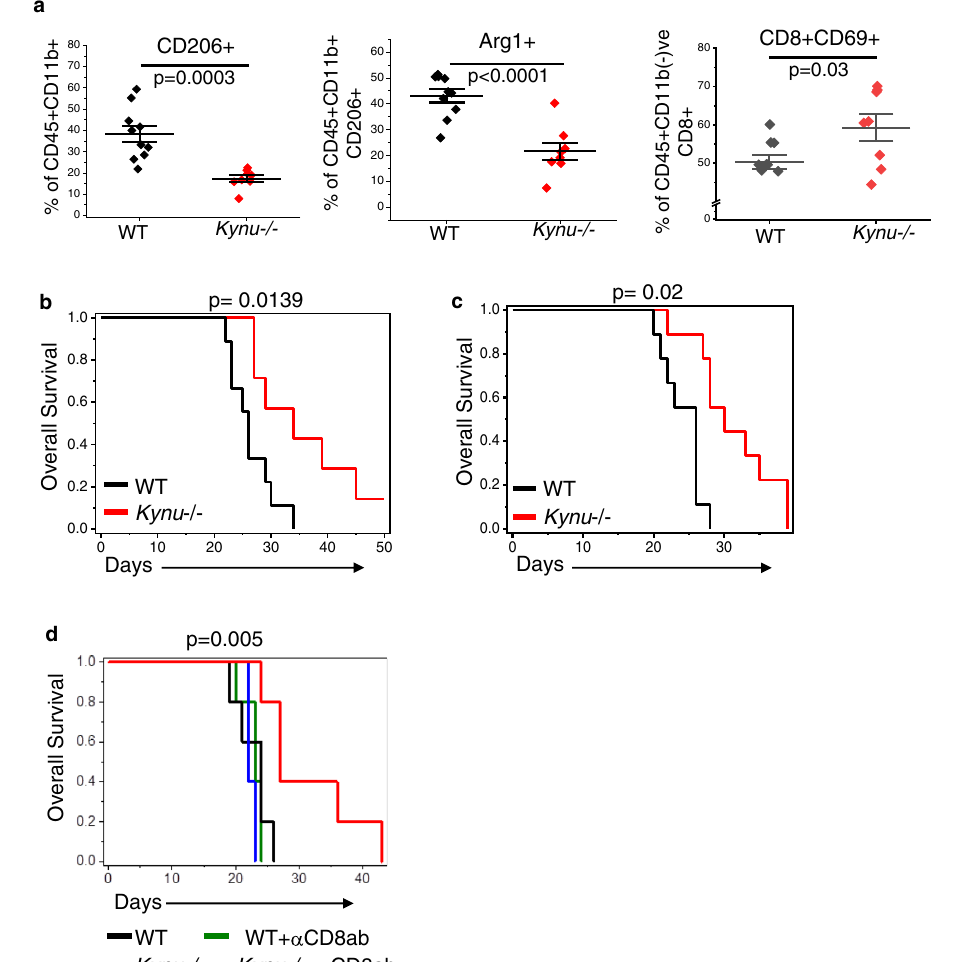
Fig. 8 | Targeting QA accumulation using the Kynu -/- model modulates the immunelandscapeanddemonstratesanti-tumoractivityinGBMinvivo.a TRP murine GBMtumors weregrown orthotopically inC57BL/6NJ WT ( n =10;black) or Kynu -/-mice( n =8;red).Micewereeuthanizedonday21and tumorsharvestedfor immune pro fi ling using fl ow cytometry, including M2 macrophages (CD45+ CD11b+F4/801+CD206+); Arginase 1+M2 macrophages (CD45+CD11b+F4/ 801+CD206+Arg1+), and activated CD8+T cells (CD45+CD8+CD69+). Line between the data points represents mean and whisker represents SE. All samples were biologically independent. b TRP murine GBM tumors were grown orthoto- picallyin C57BL/6NJWT (black; n =9/group) or Kynu -/-(red; n =7/group)miceand